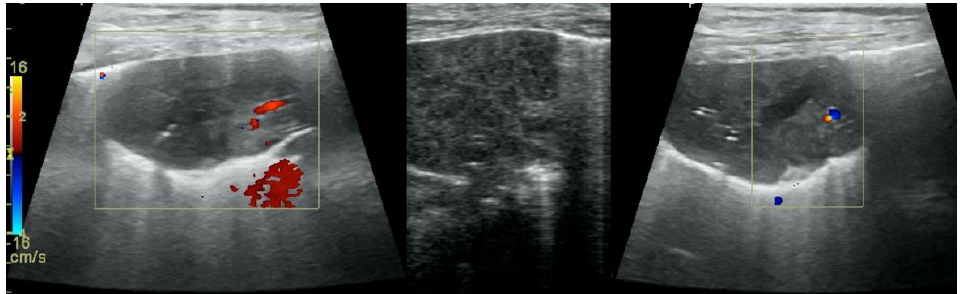
Figure 6. Hepatization without aeration in the course of lung cancer.